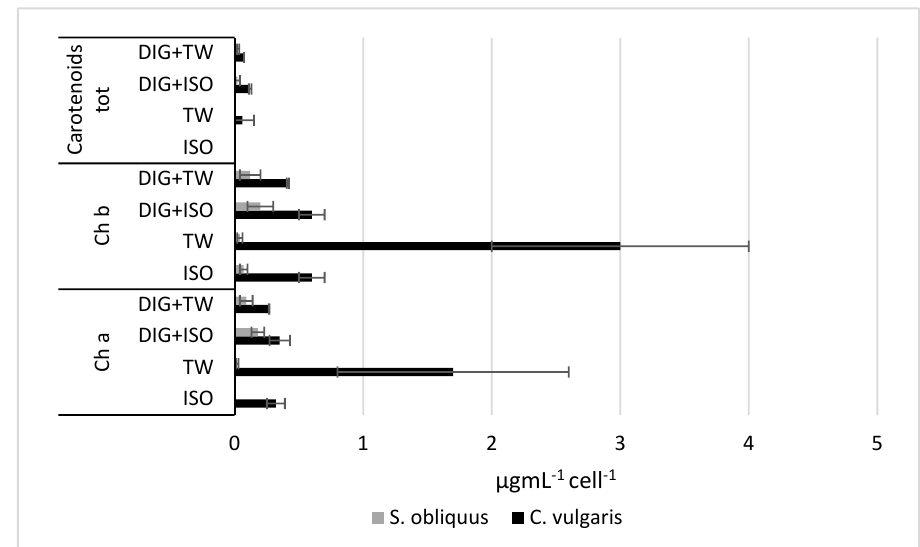
Figure 4. S. obliquus and C. vulgaris chlorophyll a , b and carotenoids accumulation in ISO, TW, DIG + ISO and DIG + TW diluted 1:5 after 8